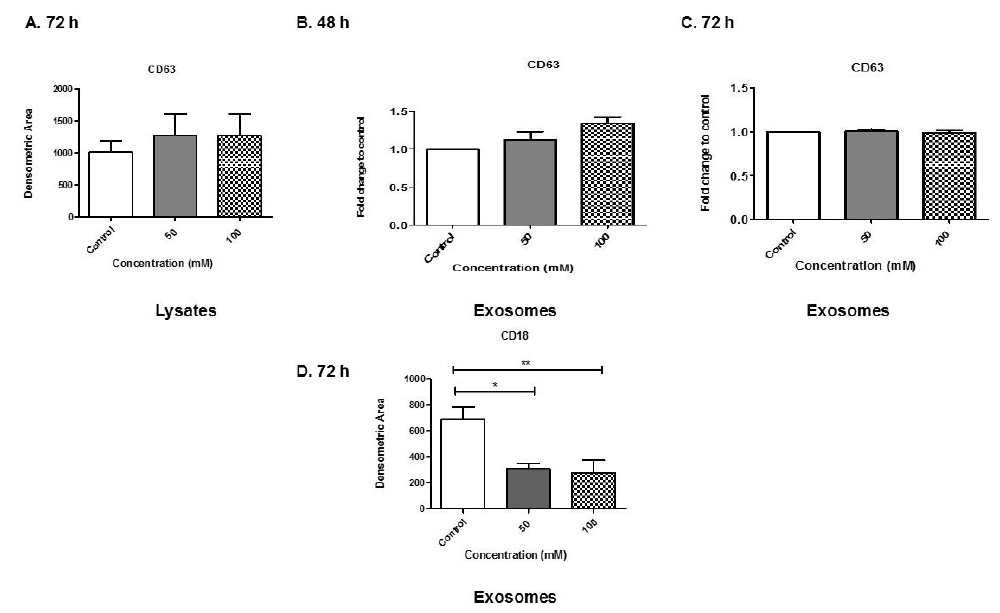
Figure 6. Expression of exosomal marker proteins. ( A ) Cell lysates (at 72 h EtOH administration) and ( B – D ) exosome proteins (at 48 and 72 h EtOH administration) were evaluated for cluster of di ff erentiation (CD)63 or CD18 expression. In order to obtain quantitative results, cell lysates were subjected to dot blot analysis and exosomes were subjected to ELISA. Experiments involving dot blot analysis and ELISA were performed with four to six independent replicates. Data are presented as mean ± SEM. Significant di ff erences were determined using one-way ANOVA with post hoc Tukey’s analysis. Significance is defined as (*) p ≤ 0.05, (**) p ≤ 0.01.